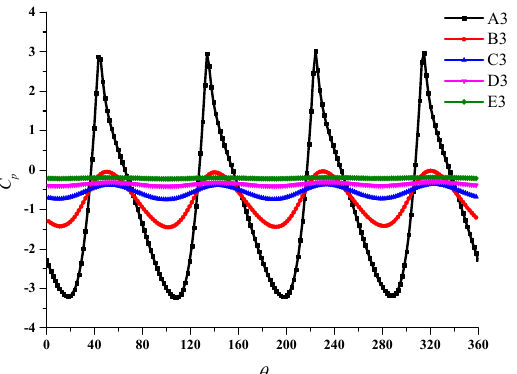
Figure 11. Distribution of impeller inlet pressure coefficient at radial coefficient of 0.5.